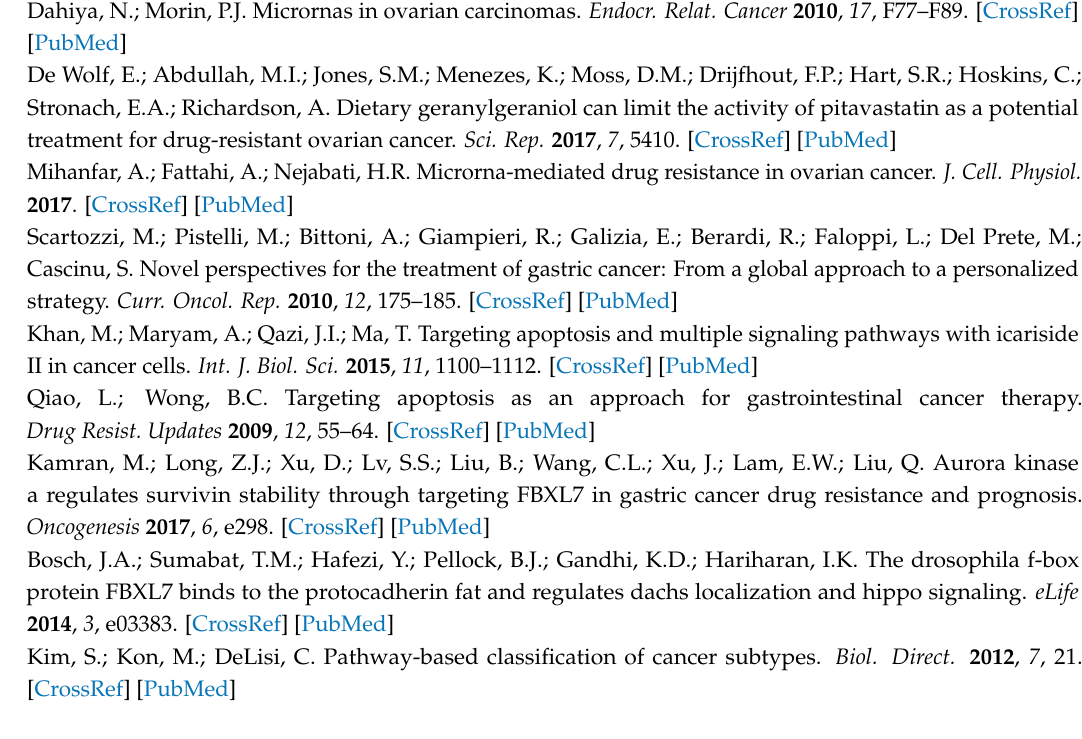
Supplementary Materials: The following are available online at http://www.mdpi.com/2077-0383/7/10/330/s1, Figure S1: Transcriptional profiling of DGKH and MFSD6 with other probe identifiers in microarray analysis against OVSAHO and KURAMOCHI cells post-treatment without or with PTX, Figure S2: Prognostic significance of different DGKH and MFSD6 probes in K-M Plotter database against ovarian cancer patients, Figure S3: Prognostic significance of different DGKH and MFSD6 probes in K-M Plotter database against ovarian cancer database, Table S1: List of consensus genes with 1.5-fold changes in KURAMOCHI and OVSAHO cells following treatment with PTX, Table S2: List of consensus upstream regulators that are computationally predicted to be activated or inhibited after PTX treatment in KURAMOCHI and OVSAHO cells, Table S3: List of consensus upstream regulators that are computationally predicted to be activated or inhibited after paclitaxel treatment in KURAMOCHI and OVSAHO